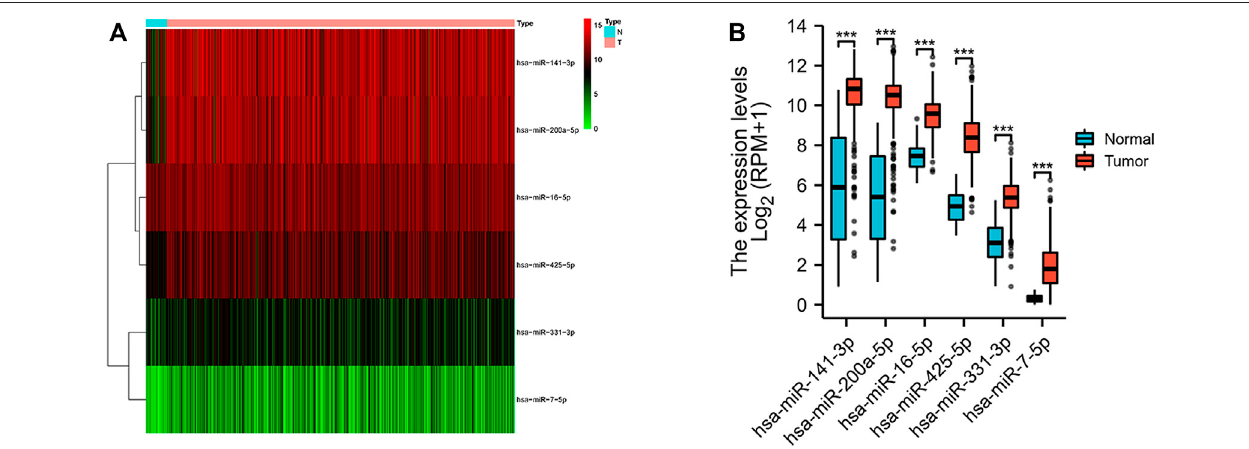
FIGURE1| Expressions ofthesixdifferentiallyexpressed necroptosis-relatedmiRNAs. (A) Heatmap (green:lowexpression level;red:high expression level)ofthe differentially expressed necroptosis-related miRNAs between the normal (N, brilliant blue) and the tumor tissues (T, red). (B) Box plot of the differentially expressed necroptosis-related miRNAs between the normal (blue) and the tumor tissues (red). *** p < 0.001.